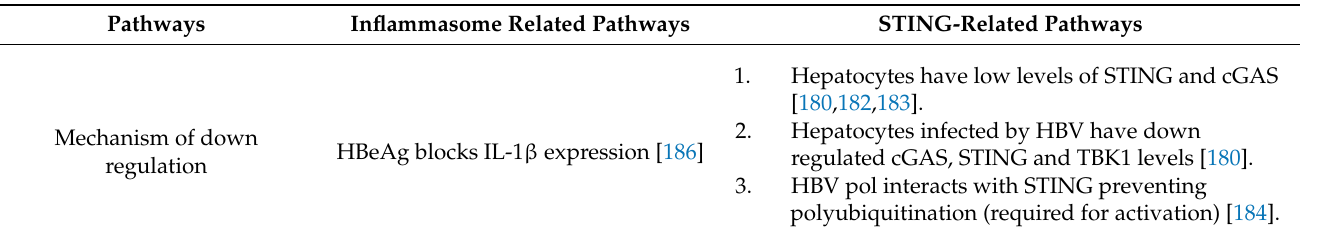
Table 4. Viral proteins and events that lead to the downregulation of innate immune sensing of HBV. Pathways Inflammasome Related Pathways STING-Related Pathways